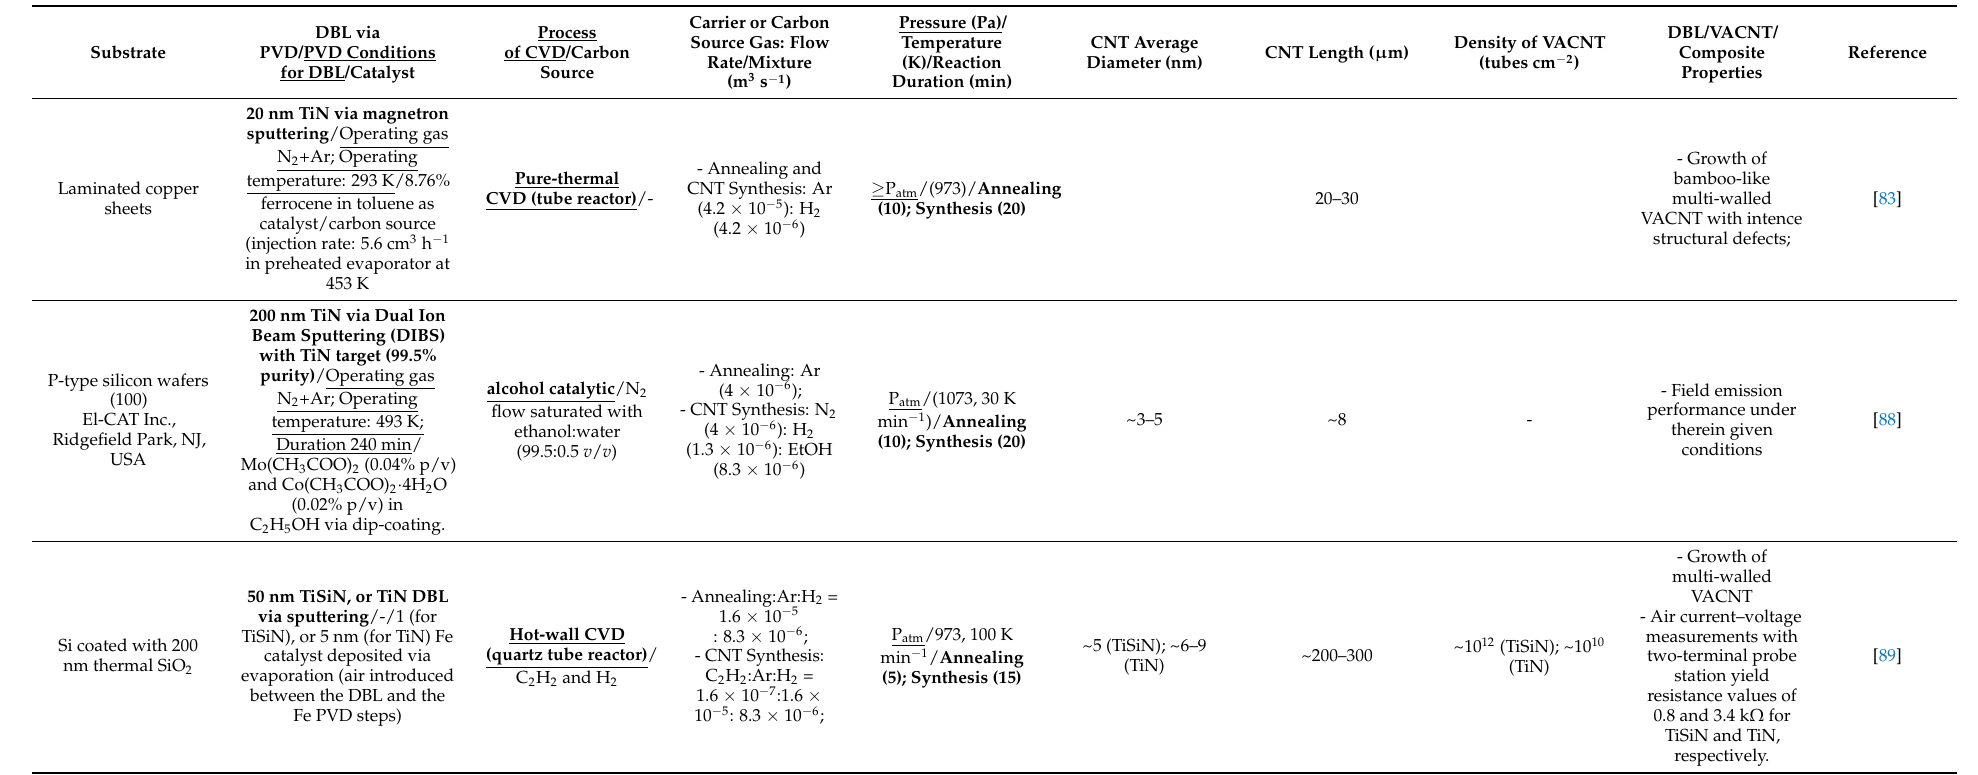
Table 4. Details of used substrate, metal nitrides/silicide-nitrides DBL without using Al top-layer (deposited via PVD), and VACNT growth conditions and